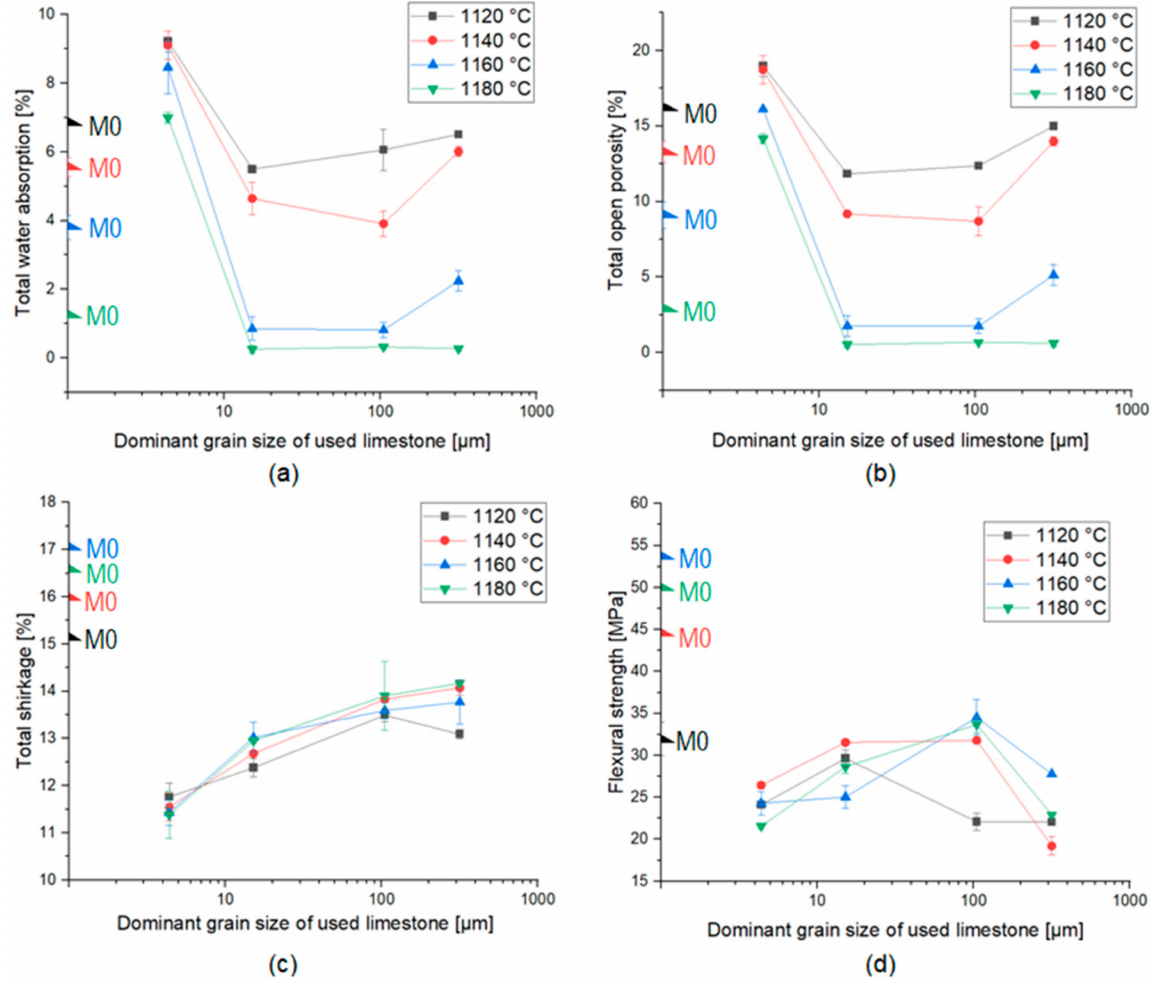
Figure 2. Results of technology properties analysis of fired ceramic materials: ( a ) total water absorp- tion, ( b ) total open porosity, ( c ) total shrinkage, ( d ) flexural